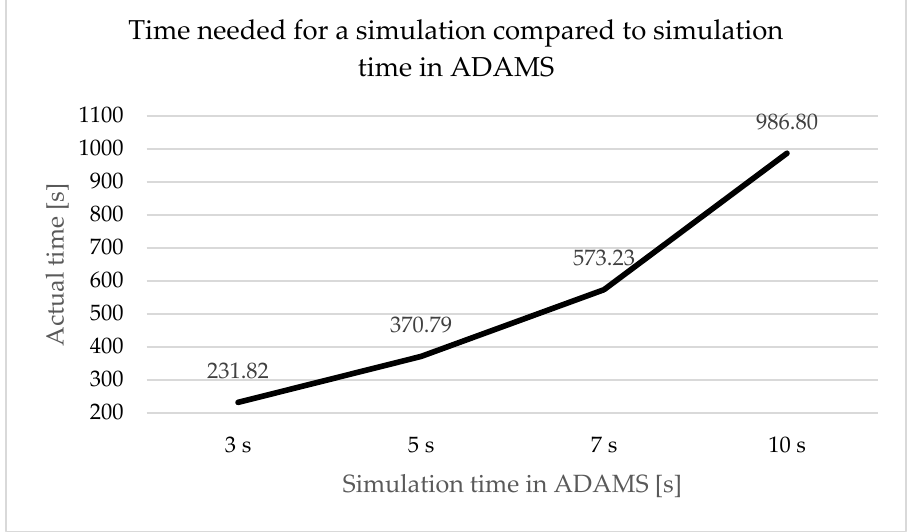
Figure 11. Time required for running 25 parallel simulations compared to simulation time (3–10 s) with the default number of workers (12). Source: own.